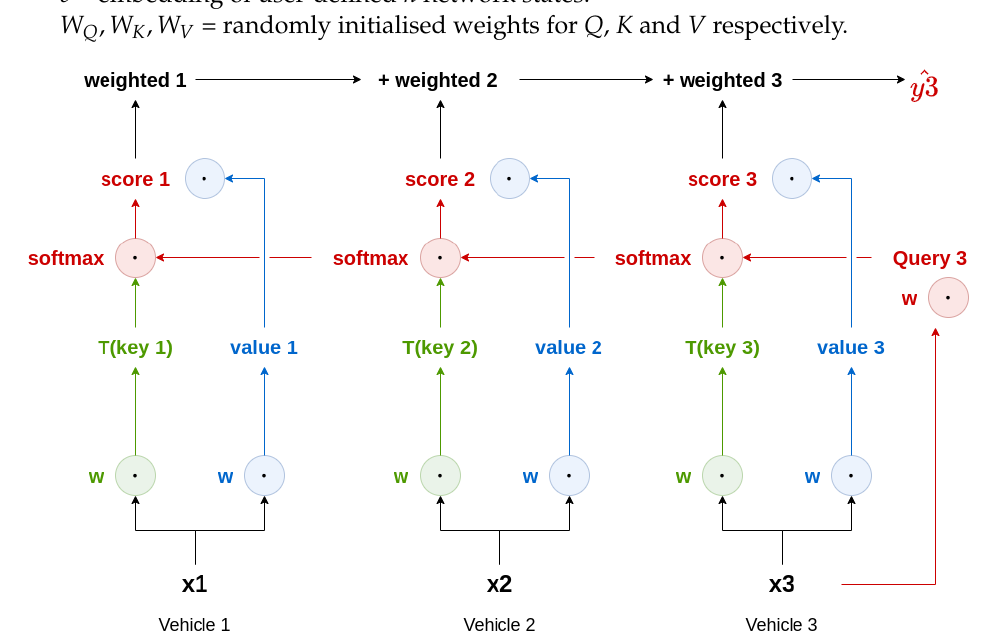
Figure 6. Schema of attention without fully connected layer or sigmoid. This illustrates the attention mechanism